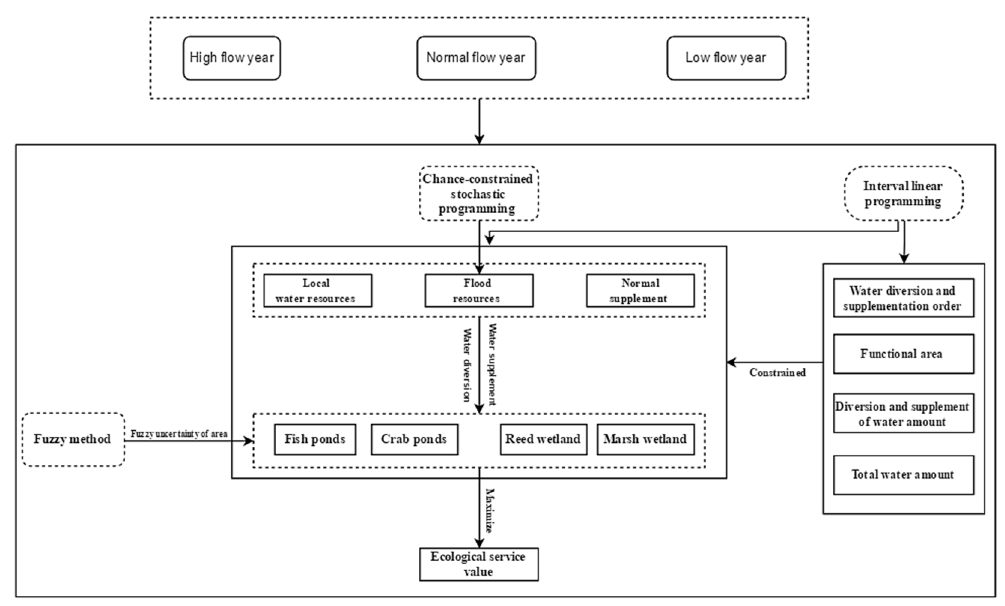
Figure 2. The flow chart of interval fuzzy, double-sided, chance-constrained stochastic programming (IFDCP) model.